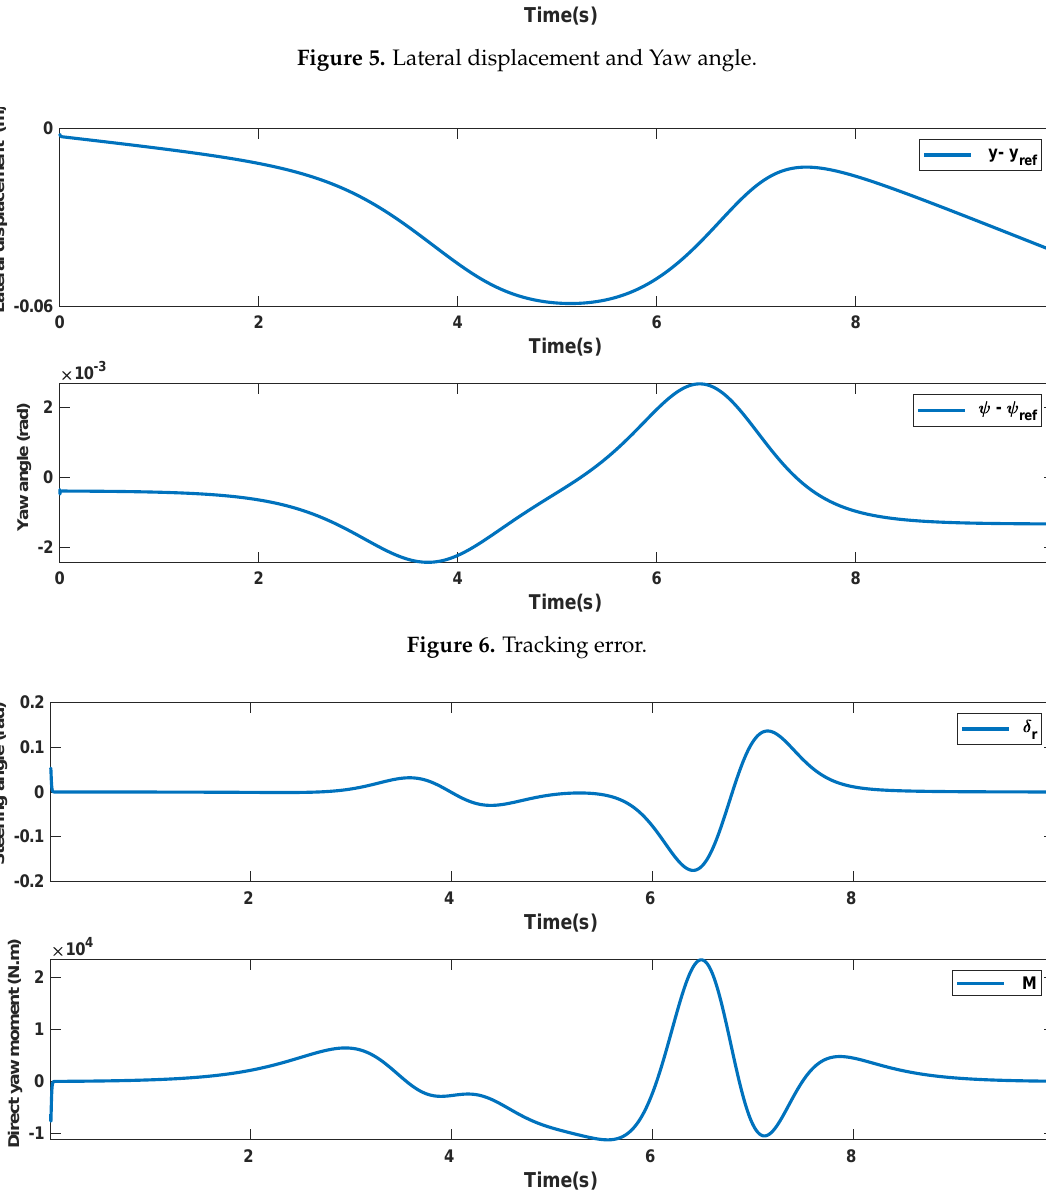
Figure 7. Control